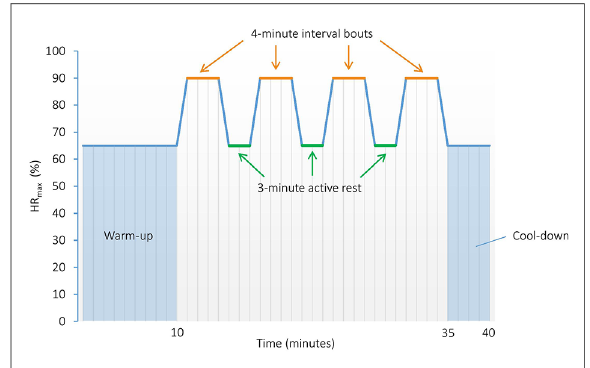
FIGURE 3 High-intensity interval training protocol performed as 4×4 min intervals. HR max , Maximal heart